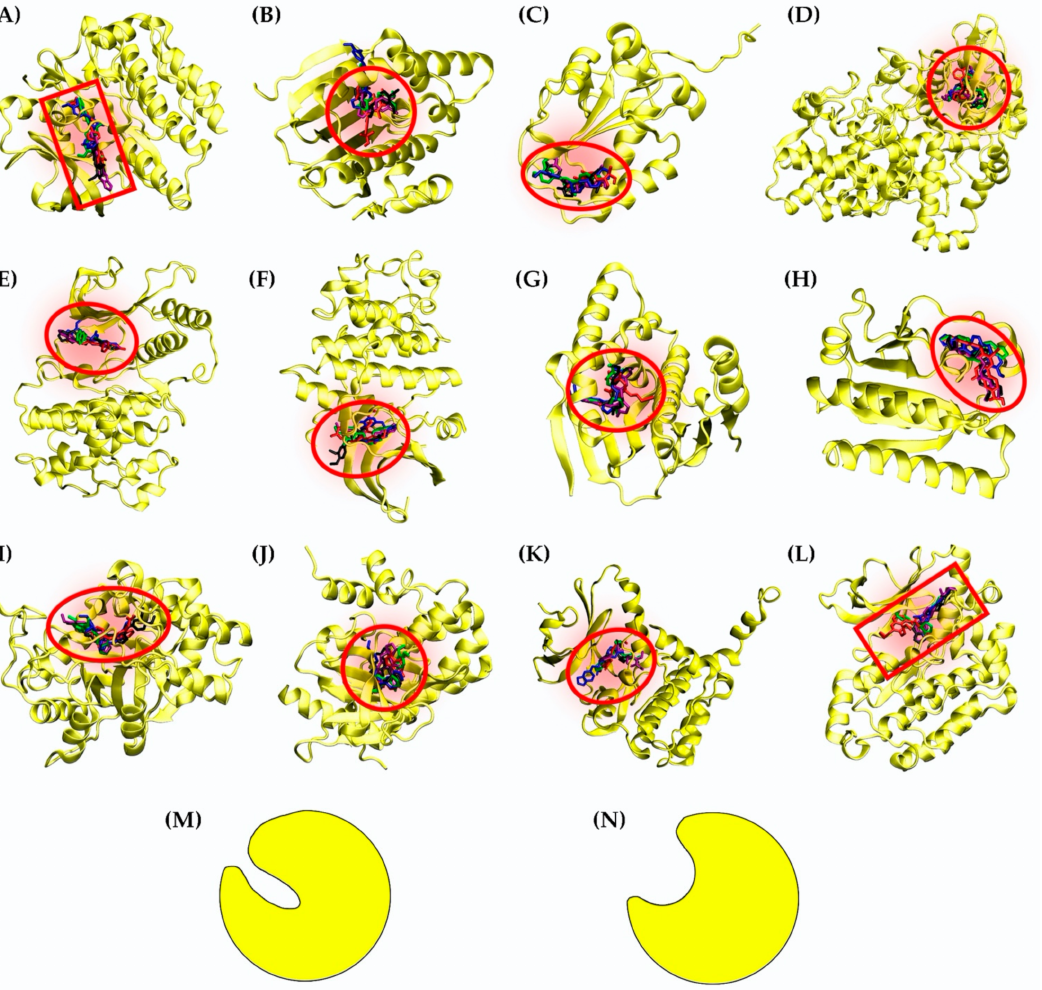
Figure 3. Kusunokinin alignment in the 12 possible targets’ binding pockets: ( A ) CSF1R; ( B ) Hsp90b; ( C ) cdc25A; ( D ) COX2; ( E ) p38; ( F ) CDK2; ( G ) Hsp90a; ( H ) RagC; ( I ) AKR1B1; ( J ) JAK3; ( K ) MNK2; ( L ) EGFR; ( M ) glove-like structure; ( N ) spherical structure. Blue, black, green and purple sticks represented the docking poses of trans -( )-kusunokinin, trans -(+)-kusunokinin, cis -( )-isomer and − − cis -(+)-isomer, respectively. The red rectangle represented the glove-like binding pocket. The red circle represented the spherical binding